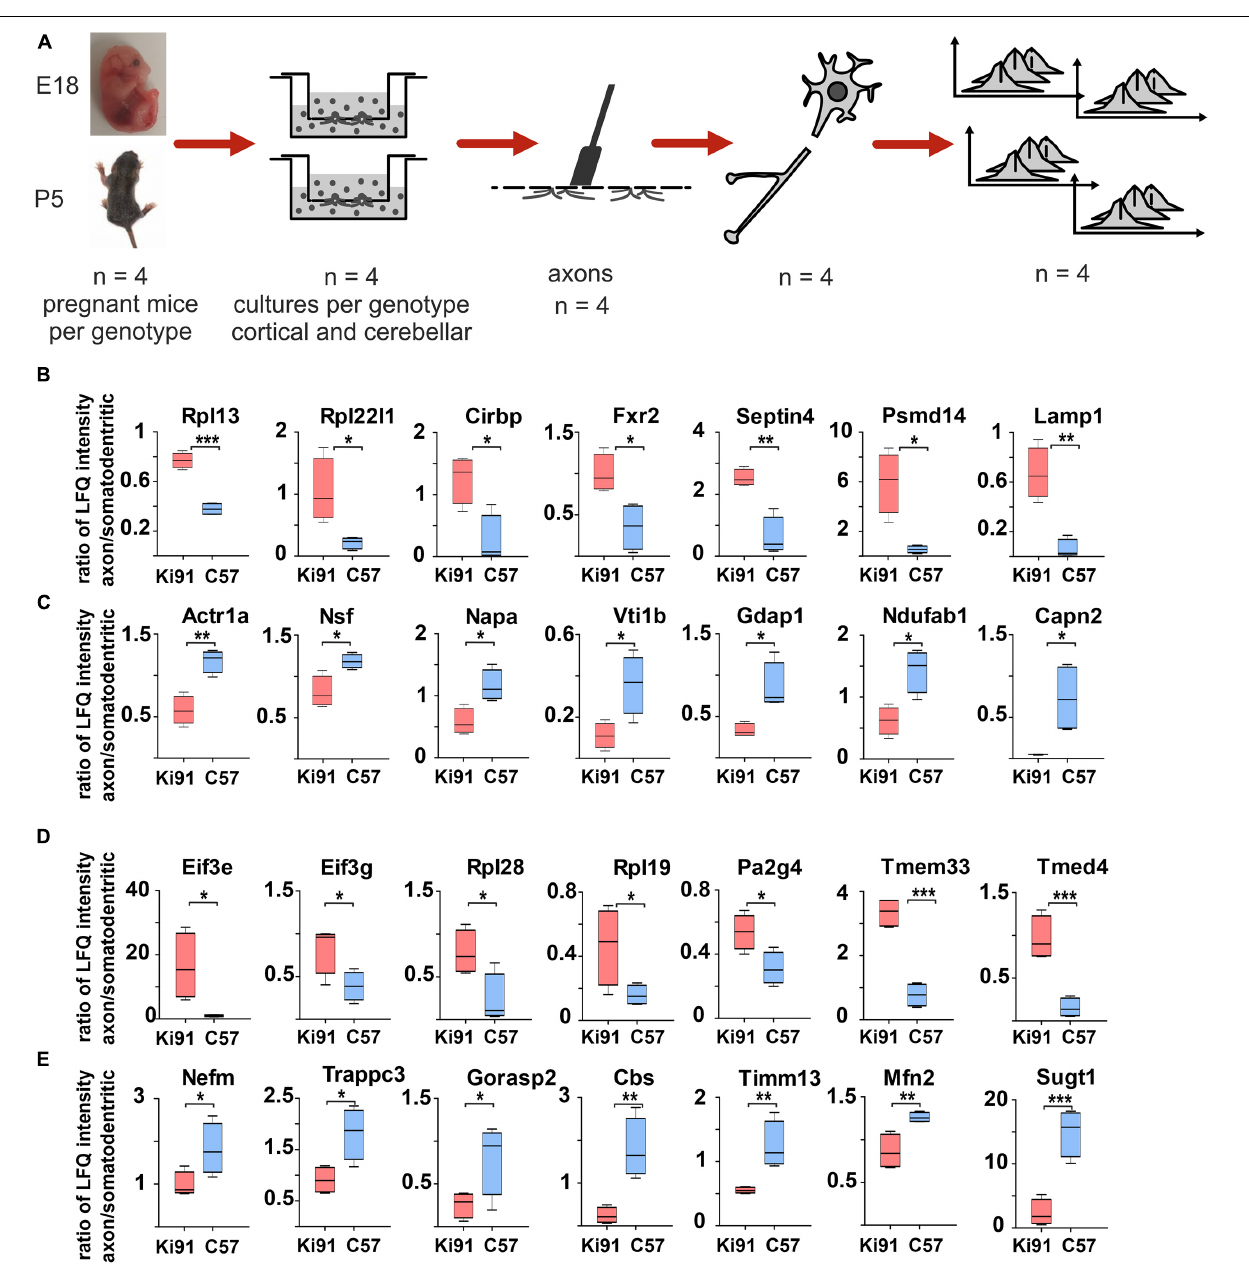
FIGURE 5 | Targeted axonal proteomics reveals sets of proteins enriched or depleted in the Ki91 SCA3/MJD cerebellar and cortical axons. Identification of proteins differentially localized in SCA3 neuronal compartments was performed by isolating two neuronal fractions (axonal and somatodendritic) from the same culture (Boyden chambers) obtained from E18 embryo (cortical) or P5 pups (cerebellar) – derived neurons. In brief, neurons were seeded on the inner side of the Boyden chamber inserts with a 1- µ m porous filter. After the period of neuronal differentiation and axonal growth through and toward the outer side of the insert membrane, both the inner side of the insert (somatodendritic) and the outer side (axonal) were scraped, and the fractions were collected for MS/MS analysis (A) . Graphs present proteins with abnormal localization between axon and soma with the highest ratio between those compartments ( p < 0.05; two-sample t -test) in the primary cerebellar (B,C) and cortical Ki91 neurons (D,E) . In the P5-derived Ki91 cerebellar axons, there were enriched proteins related to ribosomes (Rpl13 and Rpl22l1), RNA-binding (Cirbp and Fxr2), and proteasome or lysosome (Psmd14 and Lamp1) (B) . Proteins depleted in the Ki91 cerebellar axons involved important modulators of vesicular transport (Actr1a, Nsf, Napa, and Vti1b) (C) . In the E18-derived Ki91 cortical axons, there were enriched translation factors (Eif3e and Eif3g), ribosome subunits (Rpl28 and Rpl19), RNA-binding (Pa2g4), and ER and Golgi (Tmed4 and Tmem33) (D) . Proteins that were depleted in the Ki91 cortical axons included neurofilament (Nefm), related to intracellular trafficking (Trappc3 and Gorasp2), and mitochondria (Timm13 and Mfn2) (E) . two-sample t -test (* p < 0.05, ** p < 0.01, *** p < 0.001), n = 36, n = 4 per phenotype, error bars: SEM.